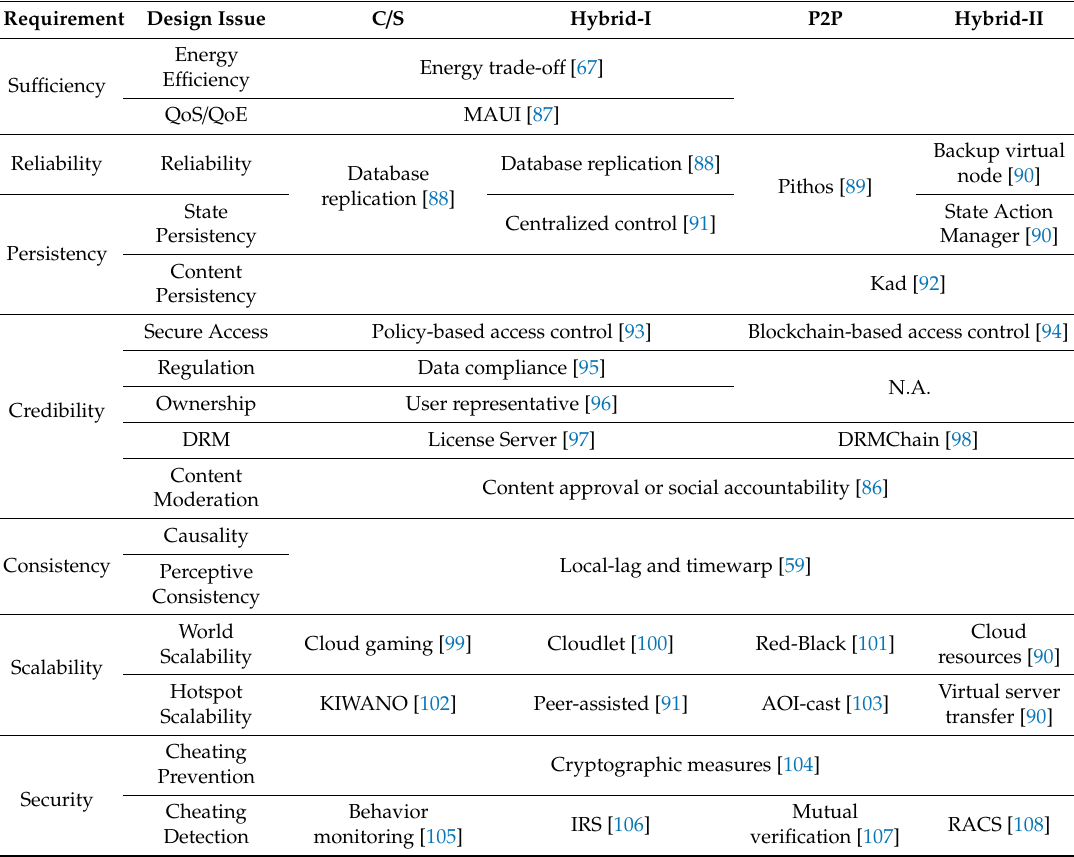
Table 1. Representative solution of the design